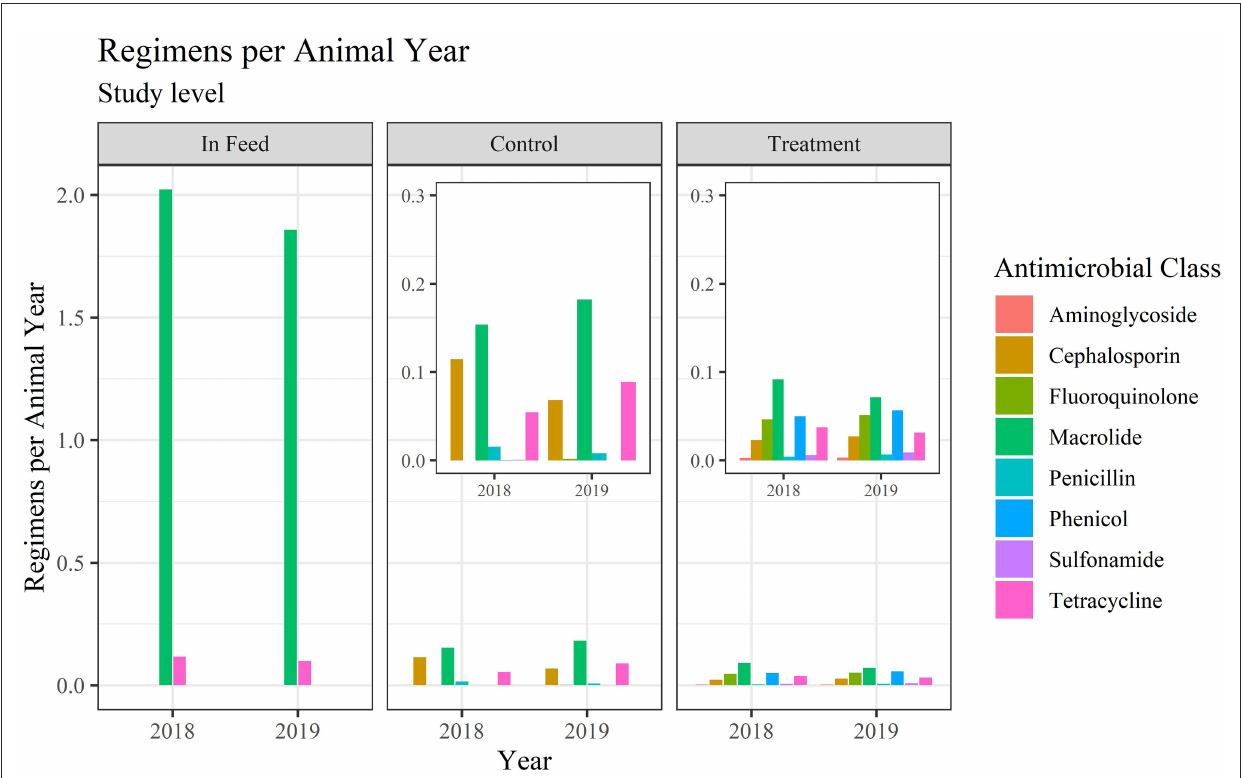
FIGURE3 Regimens per animal year for medically important antimicrobials at the study